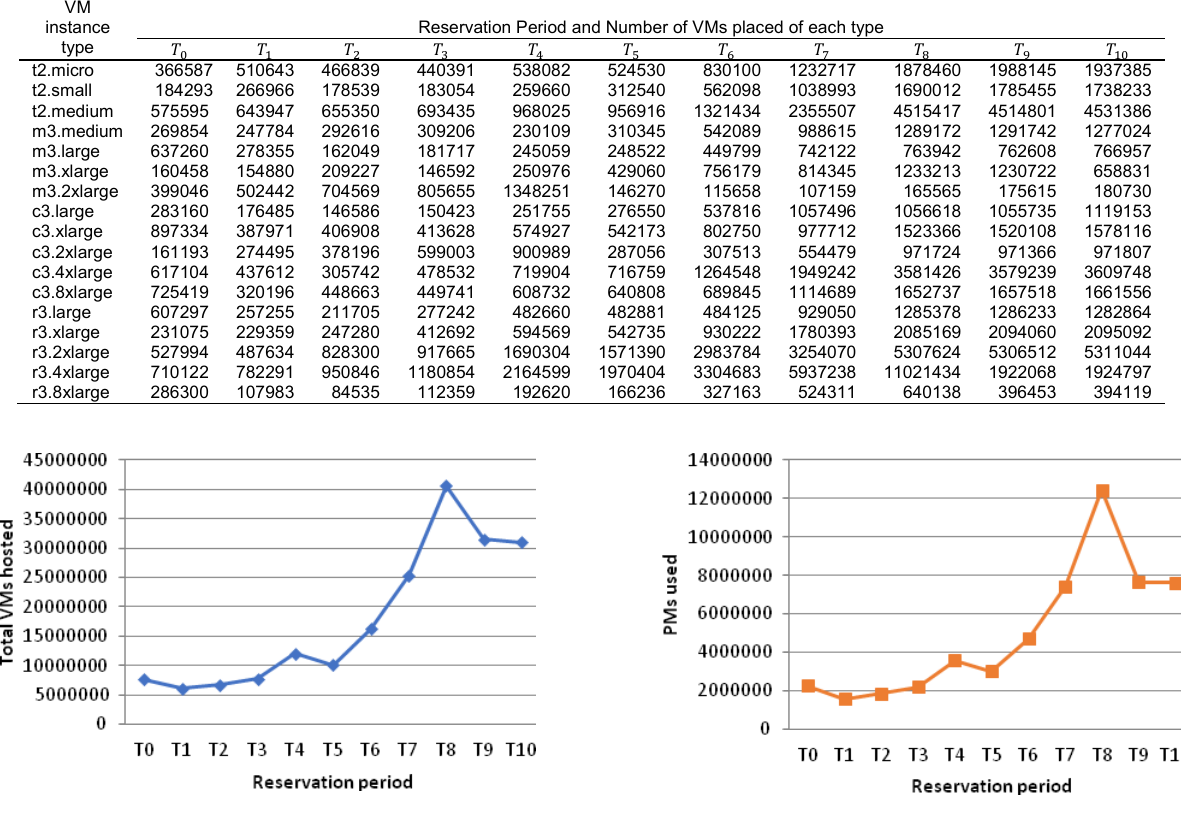
Table 5. VM request count of each type at different reservation periods VM